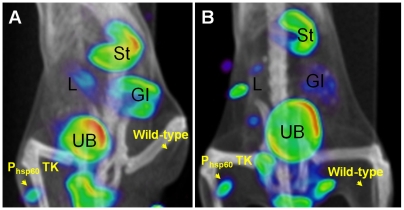
[125I]FIAU-SPECT can detect and localize Mycobacterium tuberculosis Phsp60 TK strain in situ.
M. tuberculosis H37Rv wild-type or Phsp60TK strain (∼108 CFU) were inoculated into either thighs of a BALB/c mouse. 1 mCi of [125I]FIAU was injected via a tail vein injection. Panels A and B show the fused SPECT and CT images 3 and 12 hours after the [125I]FIAU injection. Signal is detected at both time-points in the thigh inoculated with M. tuberculosis Phsp60TK strain but not in the thigh inoculated with the wild-type strain. As expected, SPECT signal is detected in several tissues [liver/gall bladder (L), stomach (St), gastrointestinal tract (GI), urinary bladder (UB)] that either metabolize or excrete FIAU or its iodinated derivatives.